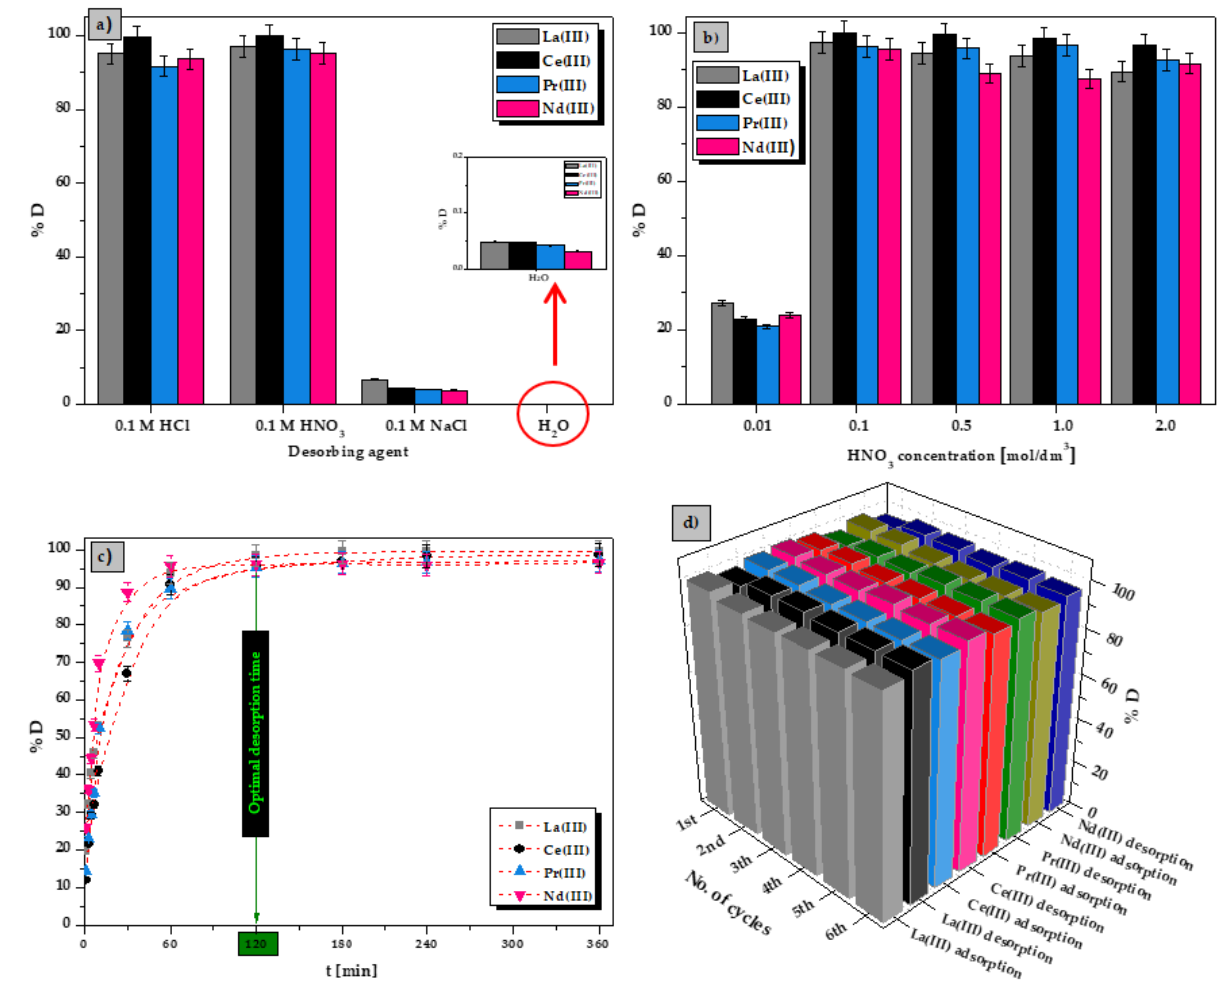
Figure 8. ( a ) Effect of desorbing agent on the La(III), Ce(III), Pr(III), and Nd(III) desorption efficiencies, ( b ) effect of HNO 3 concentration on the desorption performance, ( c ) effect of desorbing time on the La(III), Ce(III), Pr(III), and Nd(III) desorption efficiencies, ( d ) reusability studies of ALG 5 L 1 composite (conditions: m = 0.05 g, V = 20 cm 3 , t = 480 min, T = 293 K).